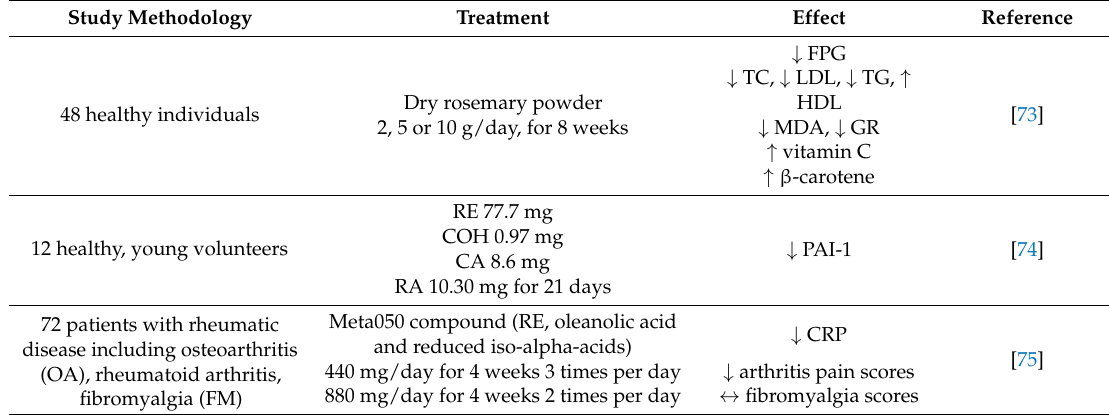
Table 7. Anti-diabetic Effects of Rosemary Extract and its Main Polyphenolic Constituents: in vivo human